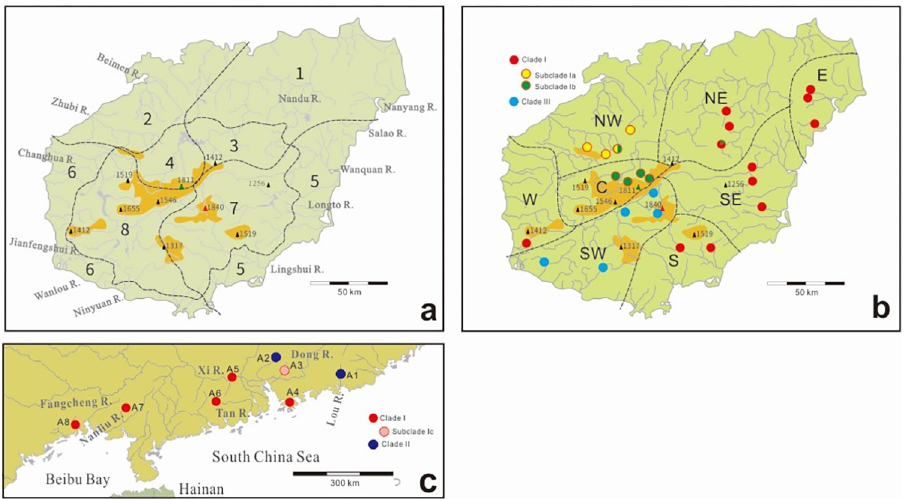
Fig 5. a, Climate ranges of Hainan Island, based on He and Zhang [36]; b, eight phylogeographic ranges inferred from this study’s cytb dataset analyses, modified by climate characteristics; c, haplotype distribution in the continental area. Sampling site locations and haplotypes at each collection site are also marked. The yellow areas in Hainan maps (a, b) indicate mountainous regions more than 750 m ASL. Red triangle: Wuzhishan Mountain. Green triangle: Yinggeling